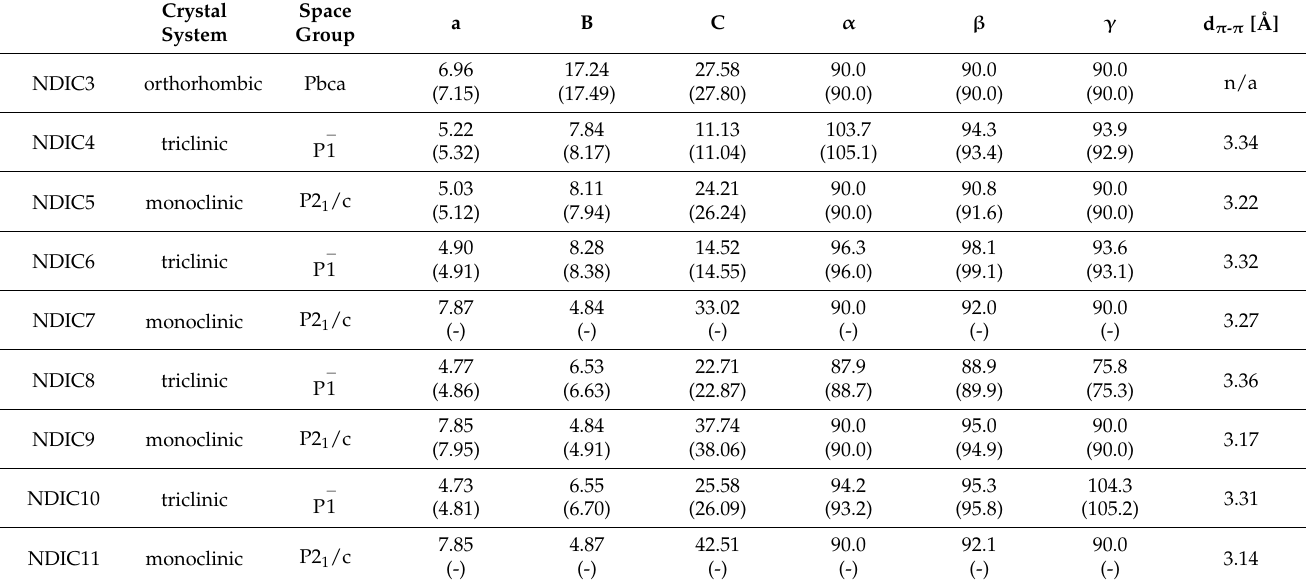
Table 2. Crystallographic data of NDIs determined from single crystal and powder X-ray diffraction patterns. Unit cell parameters determined from the powder patterns are given in brackets. The explanation for why d π - π for NDIC3 was not calculated is given in the